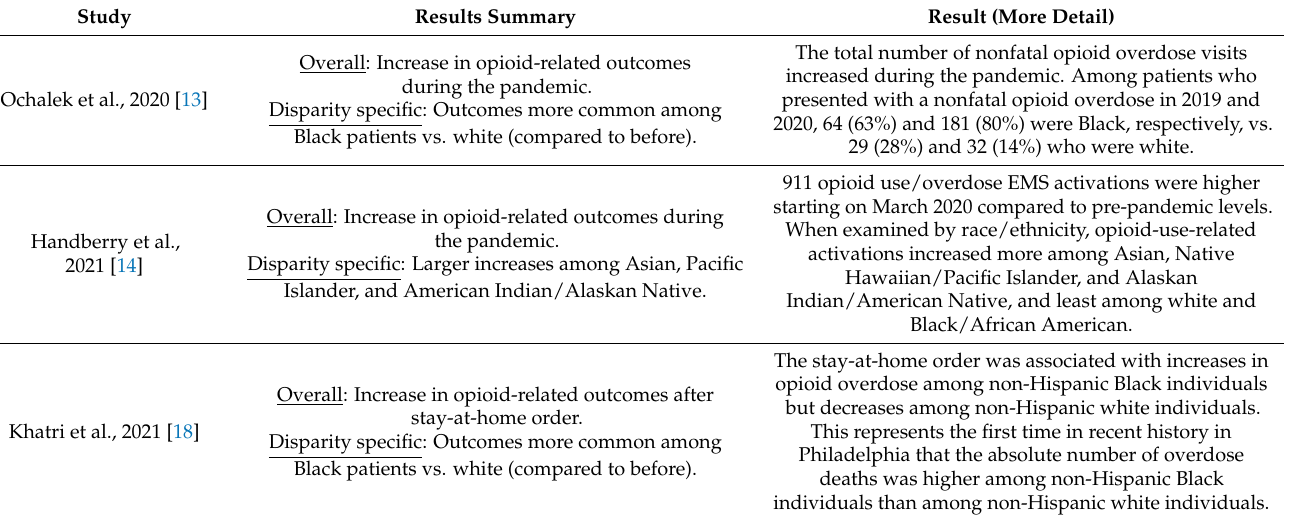
Table 2. Summary of study